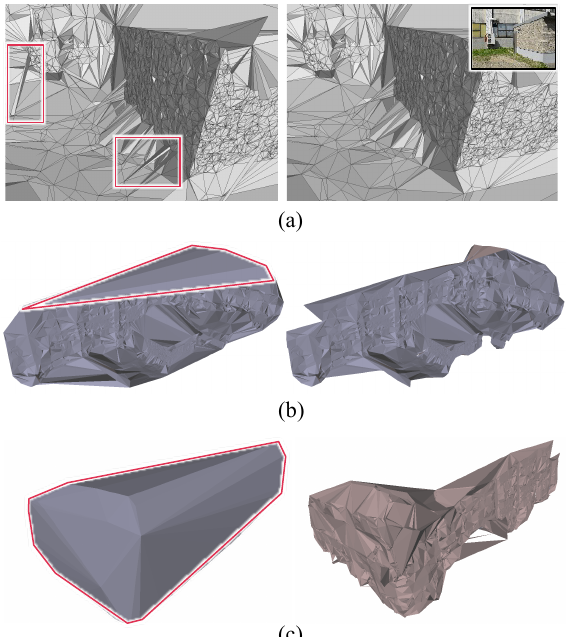
Figure 3. The examples of the proposed filtering effect. The left figures include inappropriate triangles (red frame) before filtering, the right figures after filtering: (a) locally spiky triangles, (b) widespread triangles